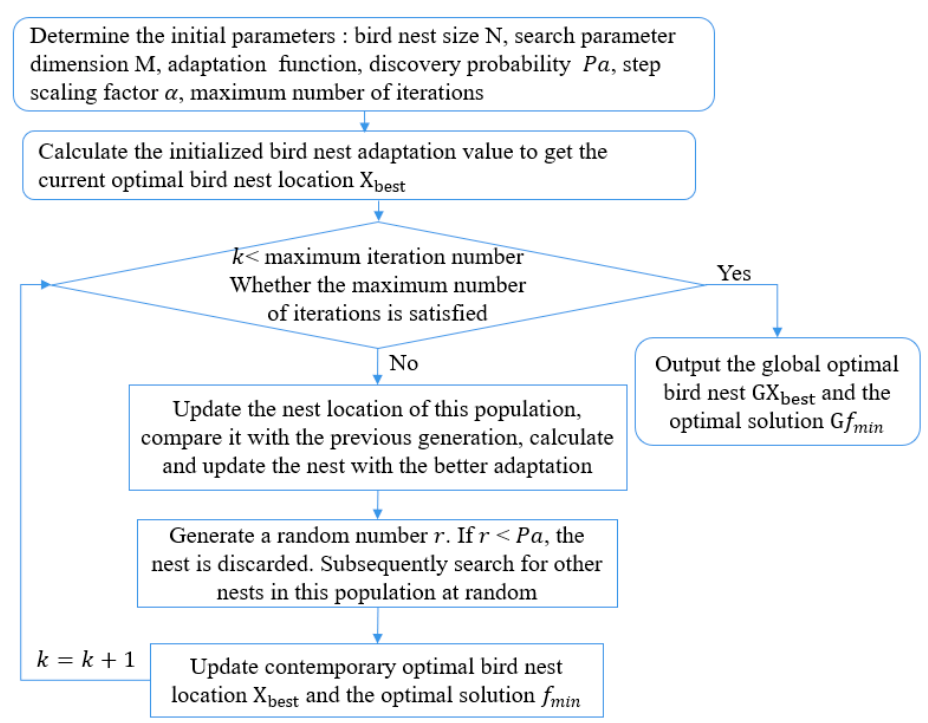
Figure 3. The overall flowchart of the cuckoo search algorithm.